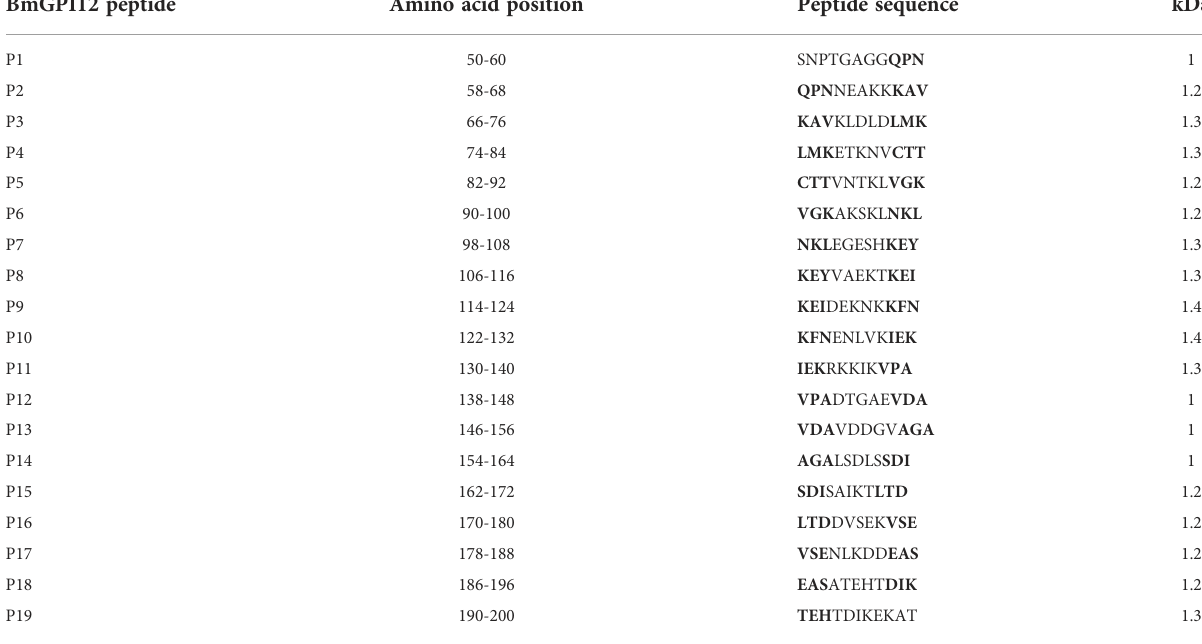
TABLE 2 Primary sequences of the BmGPI12 peptides. BmGPI12